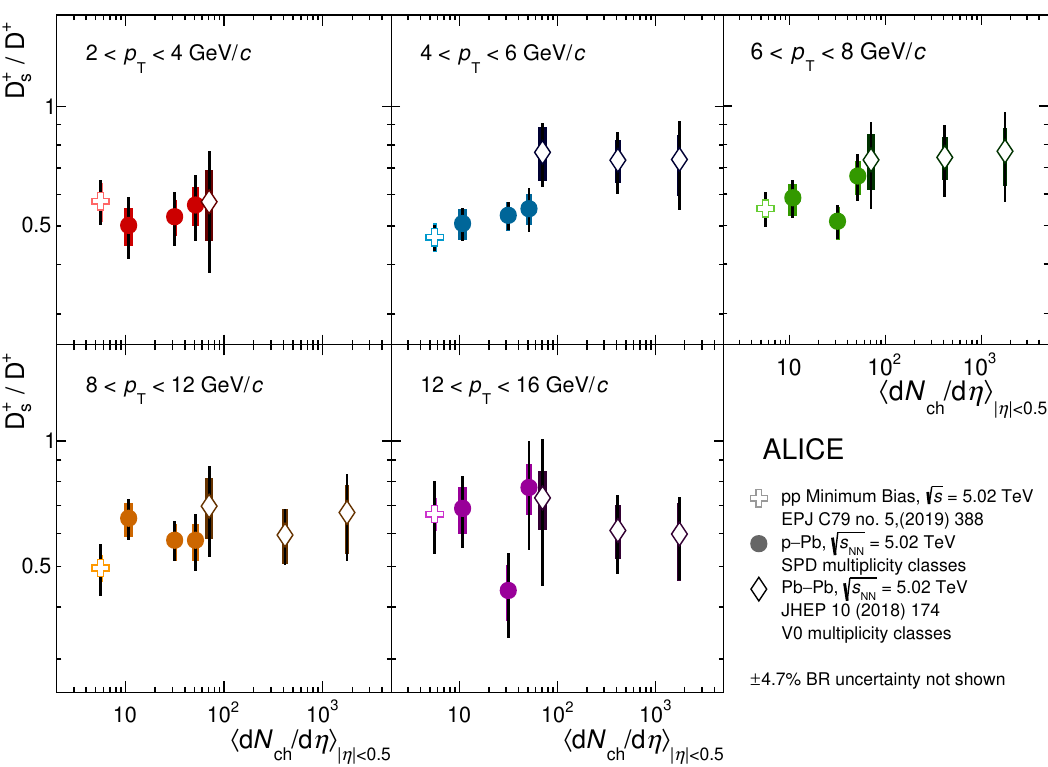
Figure 14 . D + = D + -meson yield ratios, as a function of primary charged particles per unity of s pseudorapidity in pp [70], p{Pb, and Pb{Pb [90] collisions at intervals from 2 to 16 GeV =c